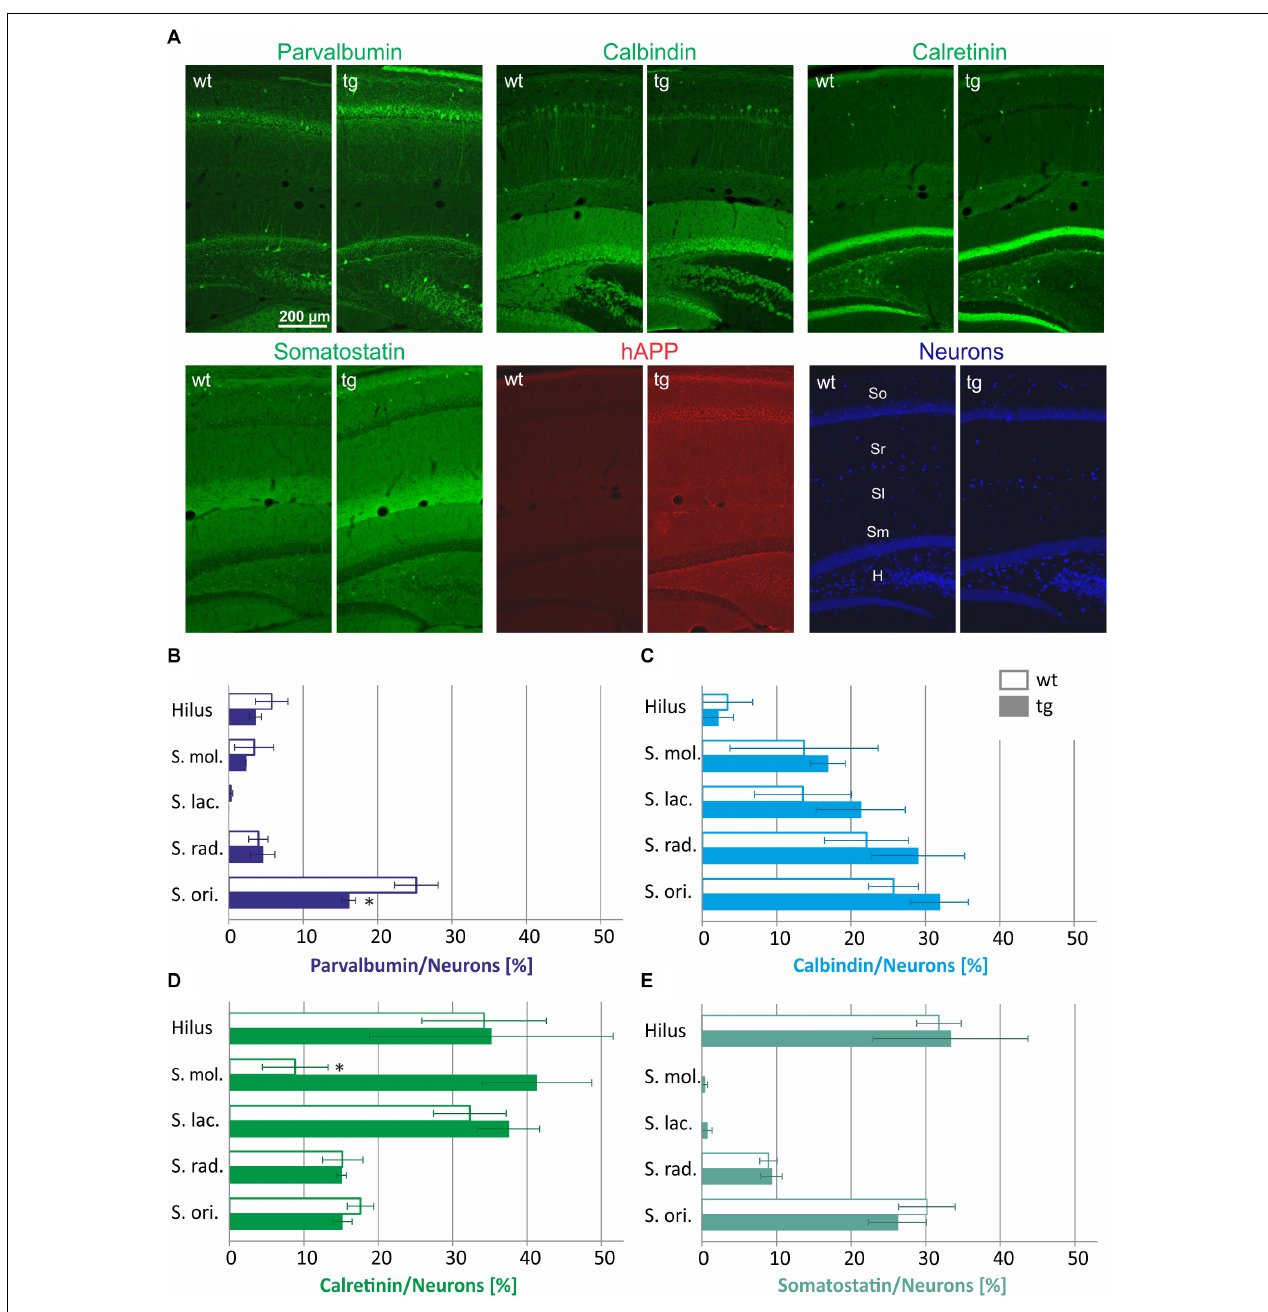
FIGURE 1 | Quantification of interneuron numbers in hippocampal layers of wild type (wt) and hAPP-transgenic Tg2576 mice (tg). In panel (A) typical staining patterns of parvalbumin-, calbindin-, calretinin-, somatostatin-, and hAPP-immunoreactive neurons are depicted in wt and tg mouse hippocampus. Note the similar labeling intensity in wt and tg brain sections for all antigens except hAPP. The hippocampal layers analyzed are indicated in the wt pan-neuronal labeling image (Neurons). In panels B–E , the proportions of parvalbumin-, calbindin-, calretinin-, and somatostatin-positive neurons in hippocampal layers of wt and tg mice are quantified. Total neuronal numbers in each layer (hilus 69.8 ± 2.8; S. mol 48.2 ± 6.7; S. lac. 68.5 ± 8.5; S. rad. 407.2 ± 49.0; S. ori. 269.5 ± 13.0) were set to 100%. Note the similar interneuron proportions in wt and tg hippocampus for most data analyzed. ∗ significantly different from wild type ( p < 0.05; unpaired t